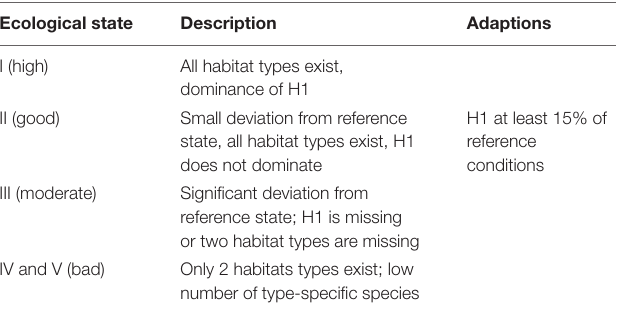
TABLE 1 | Definition of the ecological state based on the occurrence of floodplain habitat types according to Chovanec and Waringer (2001) and adaptions for the restoration scheme in the Lower